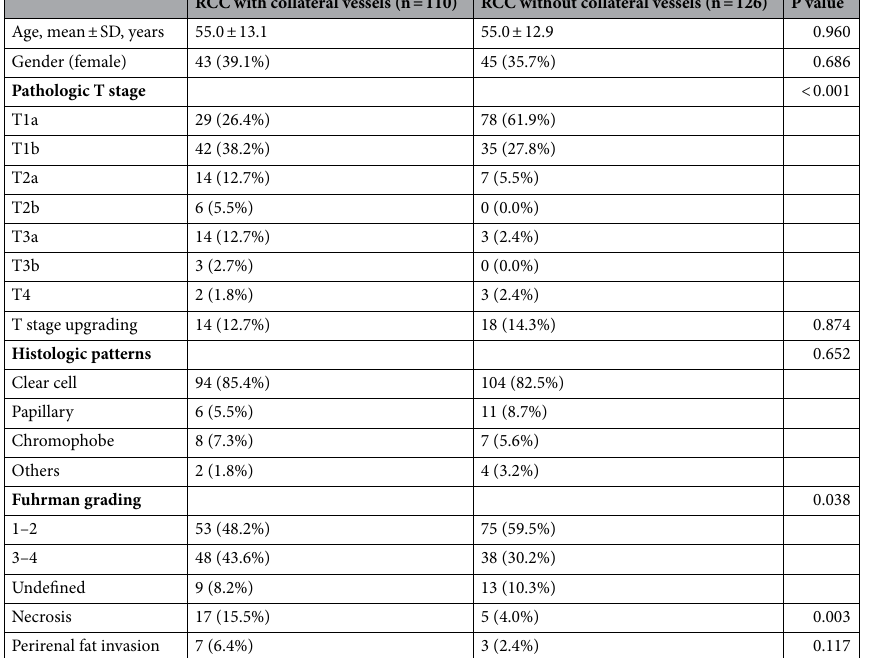
Table 1. Clinicopathological characteristics of patients with RCC. RCC renal cell carcinoma.